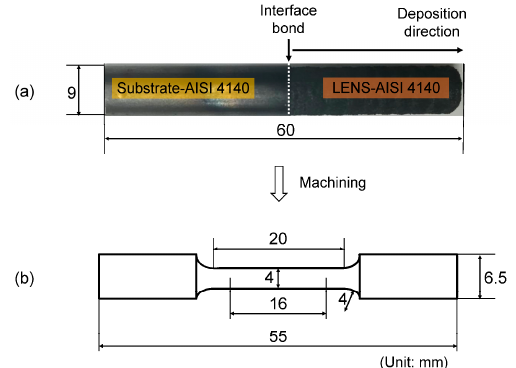
Figure 2. ( a ) Cylinder-shaped pillar after LENS deposition and ( b ) the dimensions of the hybrid test specimen after machining.